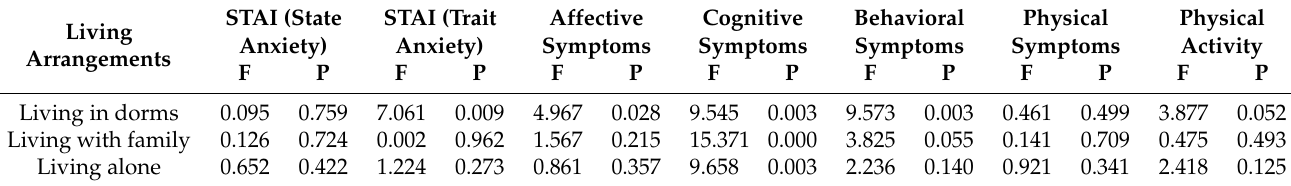
Table 7. Effects of living arrangements on STAI and students’